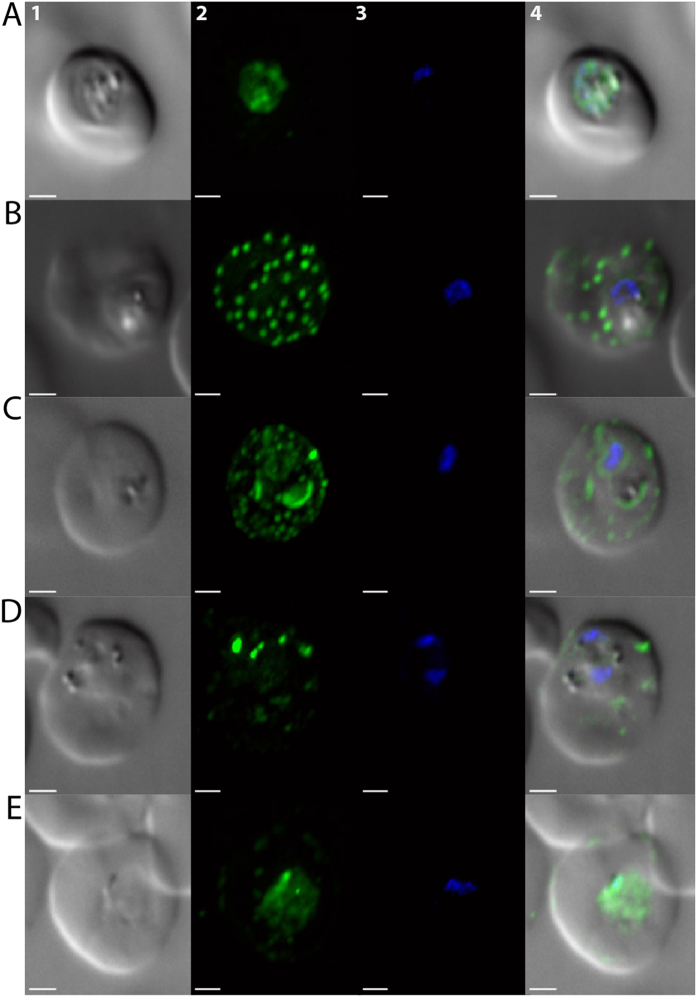
Analysis of autophagosomal body puncta formation and trafficking in response to environmental and/or pharmacological stress.Imaging and quantification of PfAtg8 containing puncta within parasite (the Plasmodium falciparum HB3 strain) infected RBC after 6 hour bolus exposure to Artemether (ATM) or ATM combinations: (A) ATM at the defined IC50 value (23 nM). (B) ATM at the defined LD50 value (80 nM). (C) ATM and Lumefantrine (LUM) at their respectively defined LD50 values (80 nM and 323 nM, respectively). (D) ATM at the defined LD50 value and GSK-2126458 at the defined LD50 value (102 μM). (E) ATM at the defined LD50 value and NVP-BGT226 at the defined LD50 value (18 nM). Panel 1: transmittance image. Panel 2: anti-PfAtg8 peptide antibody imaging (ex: 450-490, em: 500 to 550). Panel 3: DAPI nuclear staining (ex: 340–380, em: 450 to 490). Panel 4: a merged image of all three views.